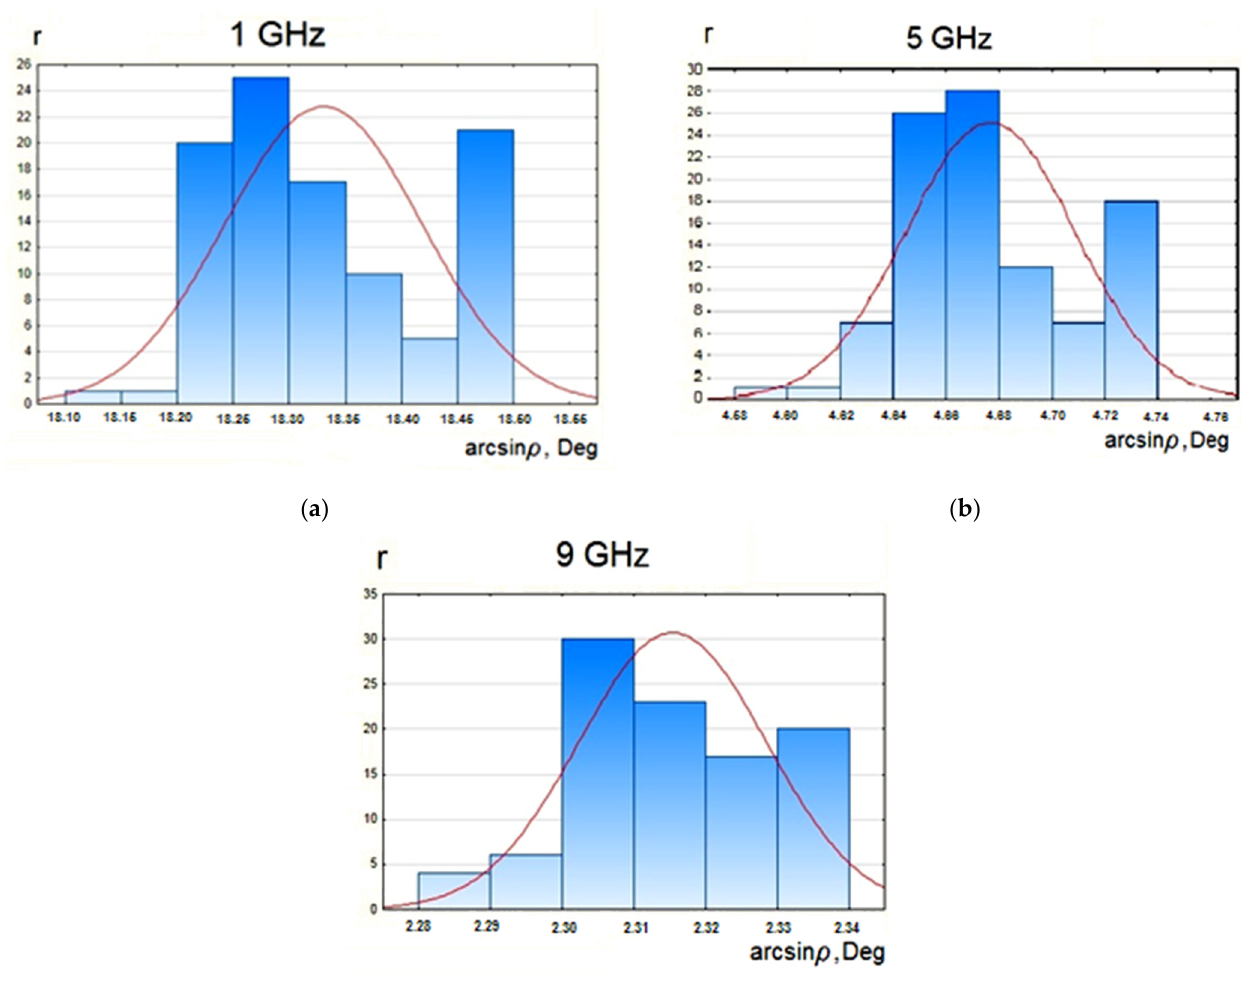
Figure 4. Histograms of the mixed wave node shift: ( a ) 1 GHz, ( b ) 5 GHz, ( c ) 9